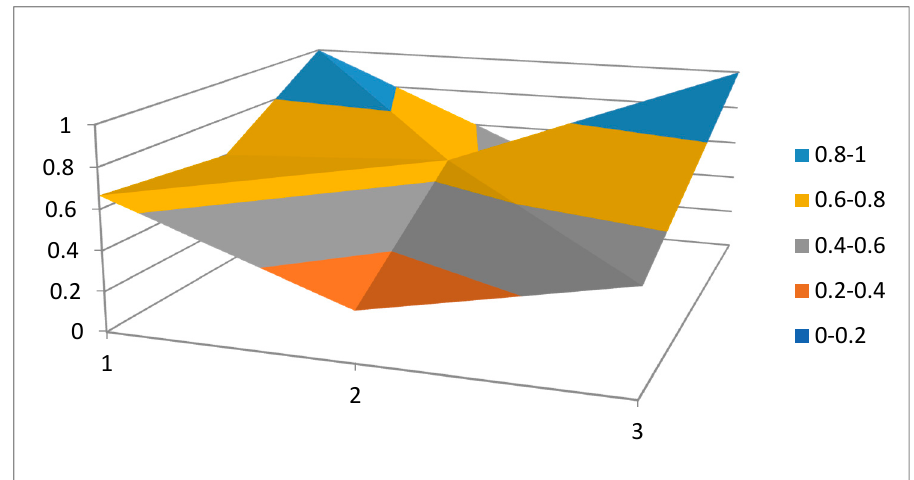
Figure 7. PMC surface of pig price control policy P4.